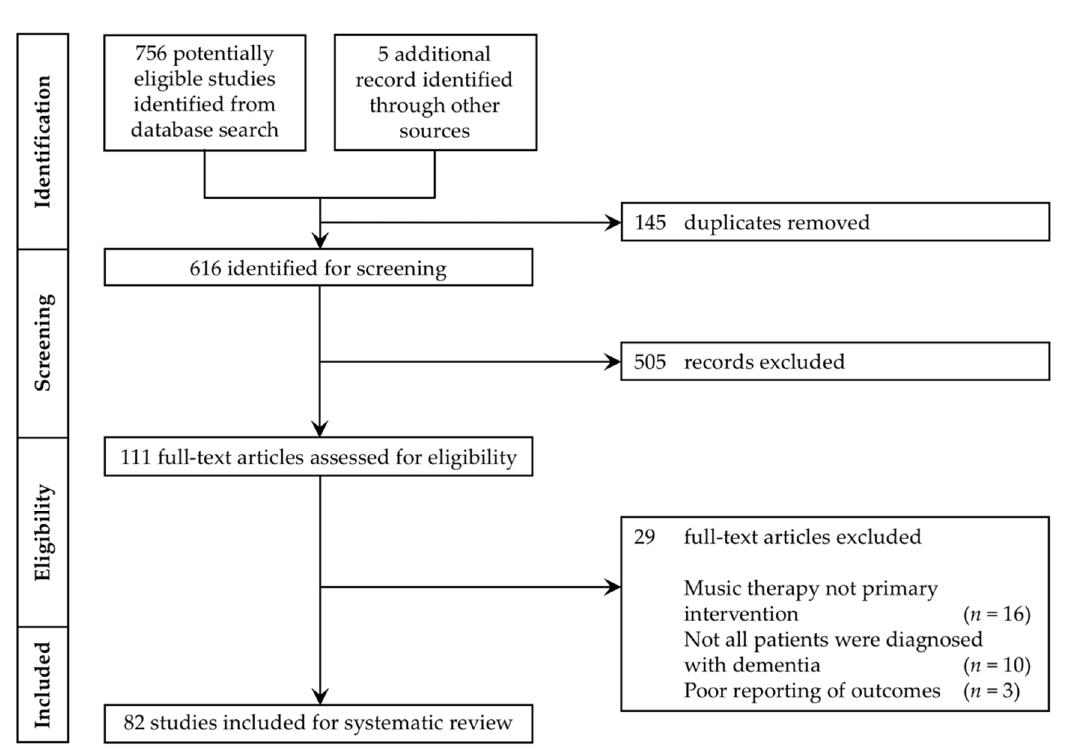
Figure 1. Preferred Reporting Items for Systematic Reviews and Meta-Analyses (PRISMA) flowchart.